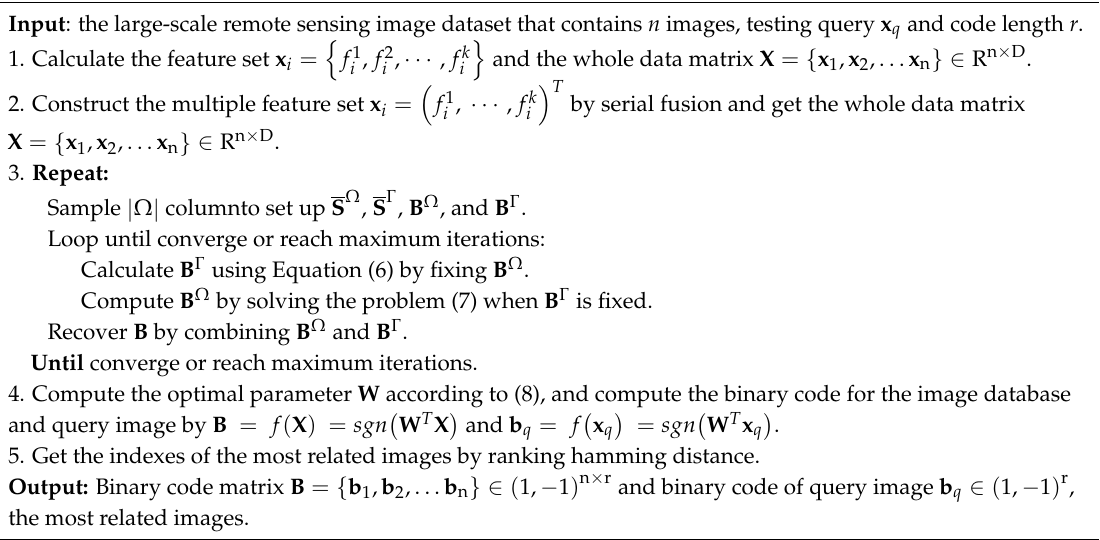
Algorithm 1. MFH-LSRSIR for large-scale RS image